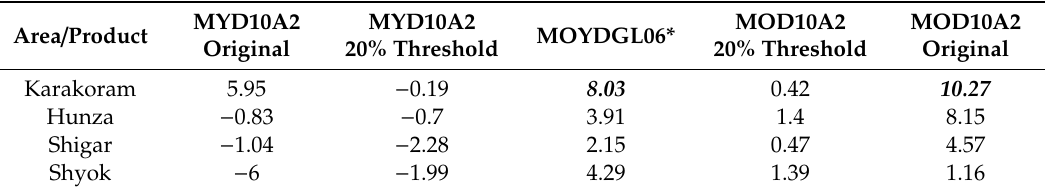
Table 5. Annual average SLA trend analysis (m a.s.l. per year) using all the snow products. Italic bold numbers are statistically significant at the 90% confidence level. Area /